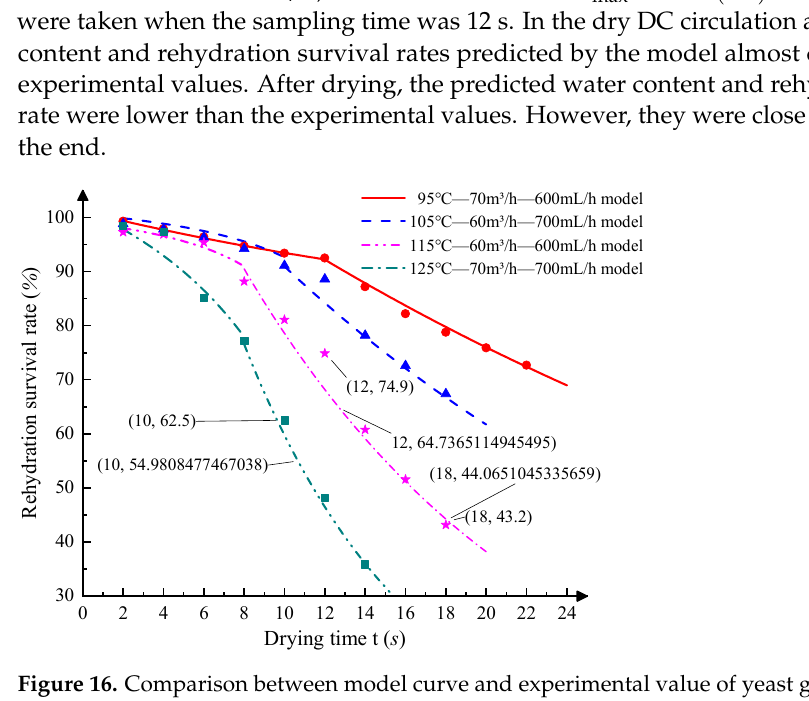
Figure 16. Comparison between model curve and experimental value of yeast granule rehydration survival rate with time.